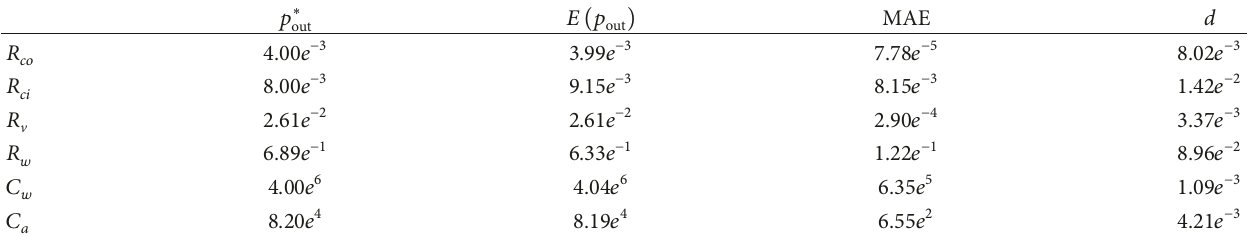
Table 5: SS to RC transformation